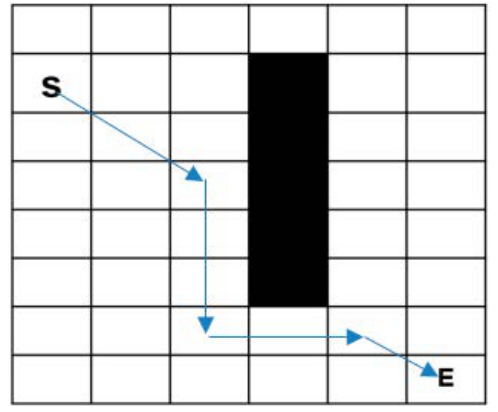
Figure 2. Optimization A-star algorithm schematic.